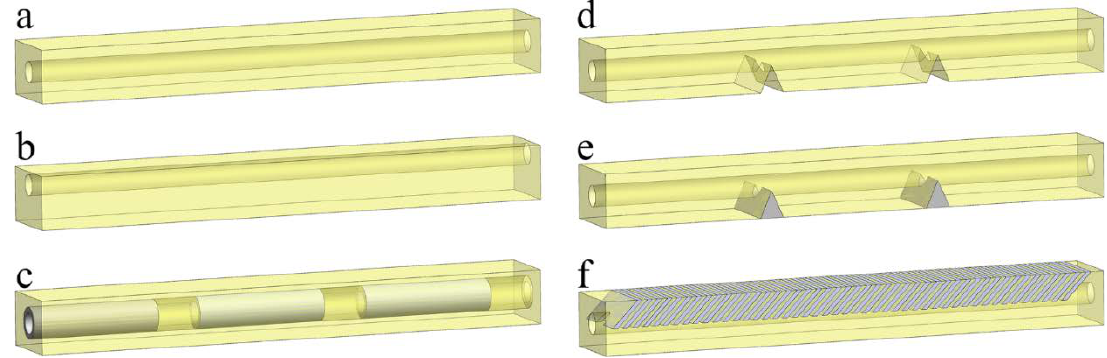
Figure 2. Geometry of the actuators with different channel positions and geometry. ( a ) Simple homogeneous actuator with central channel, ( b ) with shifted channel, ( c ) with stiff tubular inserts around channel, ( d ) with discrete notches, ( e ) with discrete stiff inserts, and ( f ) with periodic stiff inclusions structure. Shown colors are chosen to be similar to real colors of the 3D-printed materials. Yellow sections correspond to elastomeric material (TangoPlus, FLX9760 or FLX9785), while greyish inserts correspond to stiff VeroWhite material.